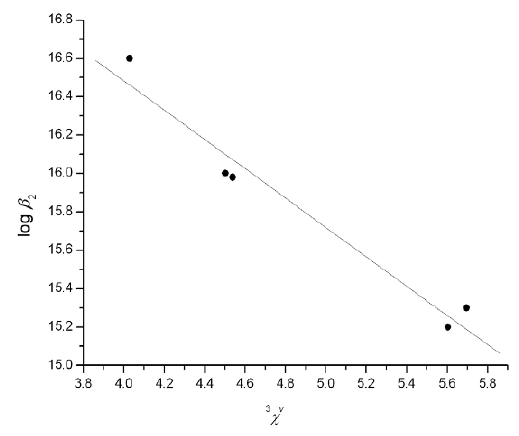
Figure 3. Experimental log β vs. 3 χ v index for Zn(II) N -salicylidene- 2 aminoacidato bis -complexes (Model 8, Table 2).